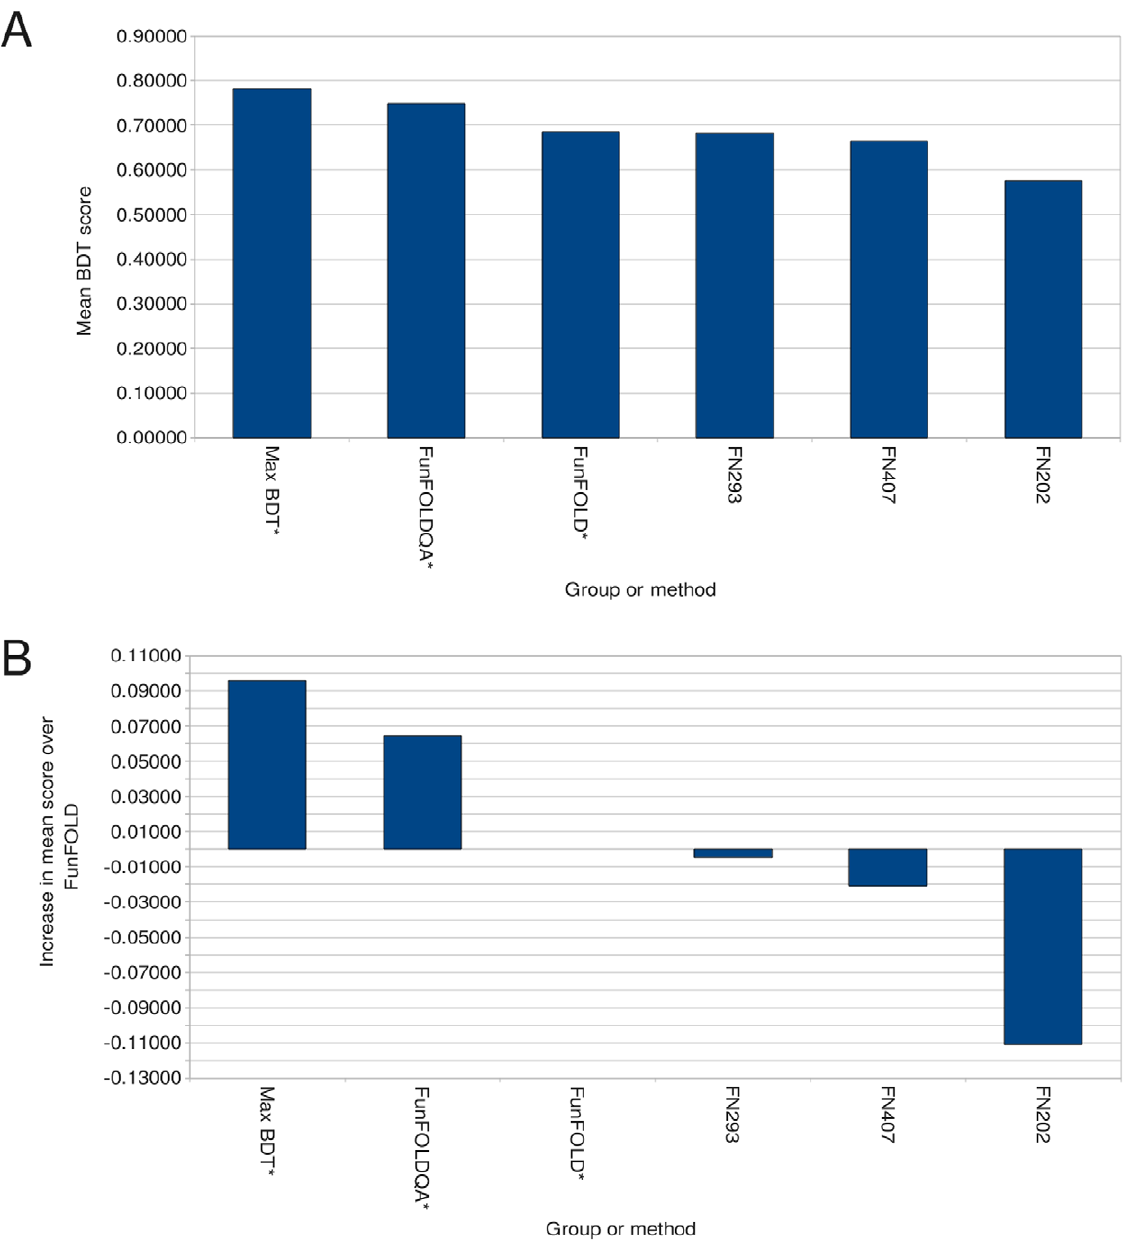
Figure 5. BDT score comparison for the CASP8 benchmarking. A) Mean per-target BDT scores for selected CASP8 function prediction groups along with FunFOLD, FunFOLDQA and the maximum score that could be obtained from FunFOLD. B) The added value, or increase in mean per-target score over FunFOLD (Minimum of 15 predictions) * indicates server method.